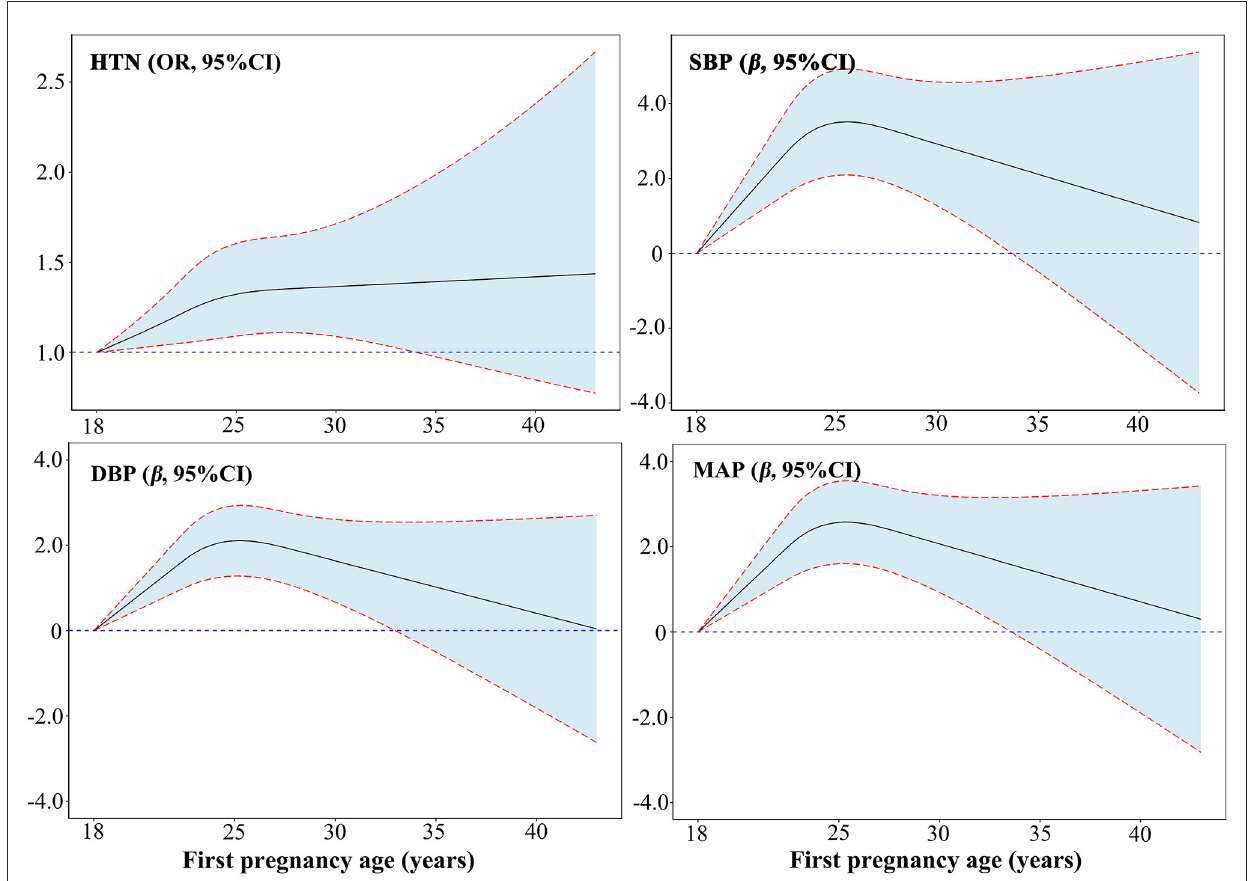
FIGURE2 Dose–responsive relationship of first pregnancy age with hypertension, SBP, DBP, and MAP from restricted cubic splines. Adjusted for age, marital status, education level, family per capita yearly income, smoking, alcohol consumption, physical activity, adequate intake of vegetables and fruits, high-fat diet, family history of hypertension, BMI, age at menarche, menopause status, breastfeeding, use of oral contraceptive pills, gestational hypertension, gestational diabetes mellitus, parity, and age at last